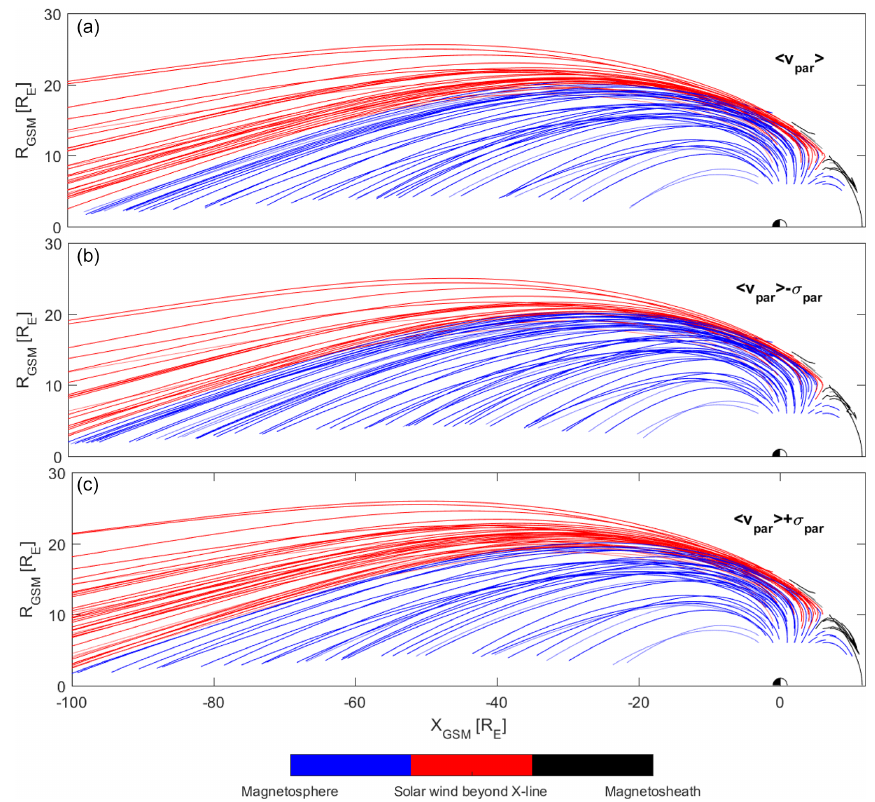
Figure 8. Tracing results using initial parallel velocities. Individual lines show the paths of particles from each measurement bin. Colors indicate the fate of oxygen ions: blue indicates that they will return to the magnetosphere (mostly plasma sheet), red indicates ions ending up in the solar wind, and black indicates ions escaping into the dayside magnetosheath. Different panels represent cases for different starting velocities: (a) shows results using average velocities, (b) shows results using lower standard deviation velocities and (c) shows results using upper standard deviation velocities.